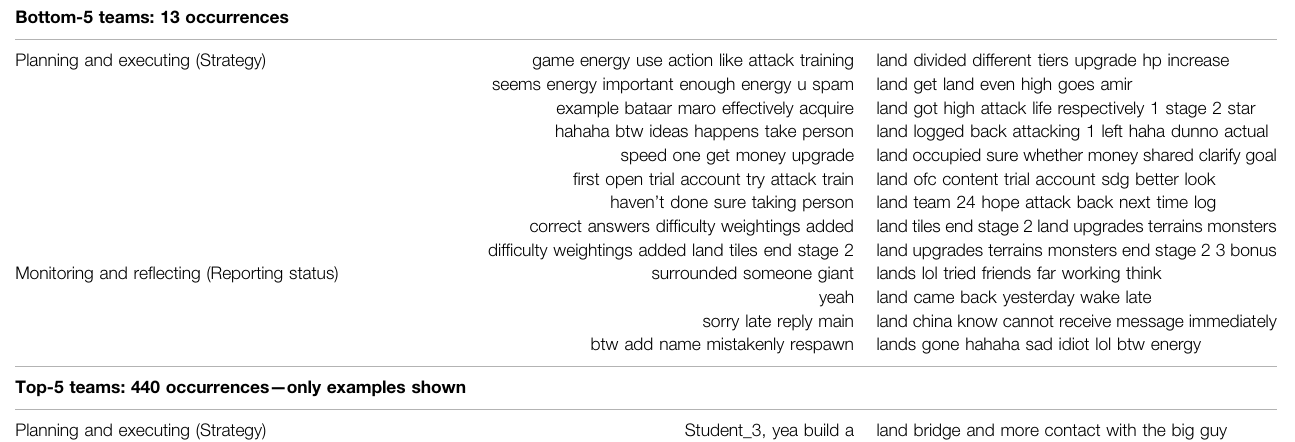
Top-5 teams: 440 occurrences — only examples shown Planning and executing (Strategy)